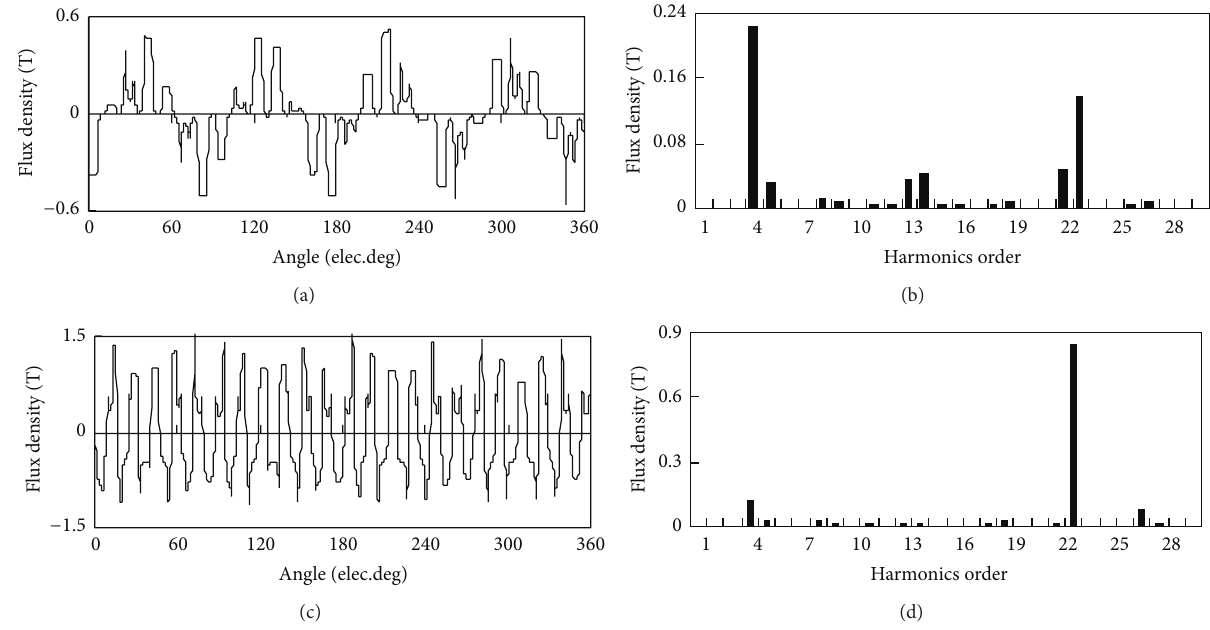
Figure 3: Radial magnetic field waveforms: (a) inner air-gap, (b) inner harmonic spectrum, (c) outer air-gap, and (d) outer harmonic spectrum.